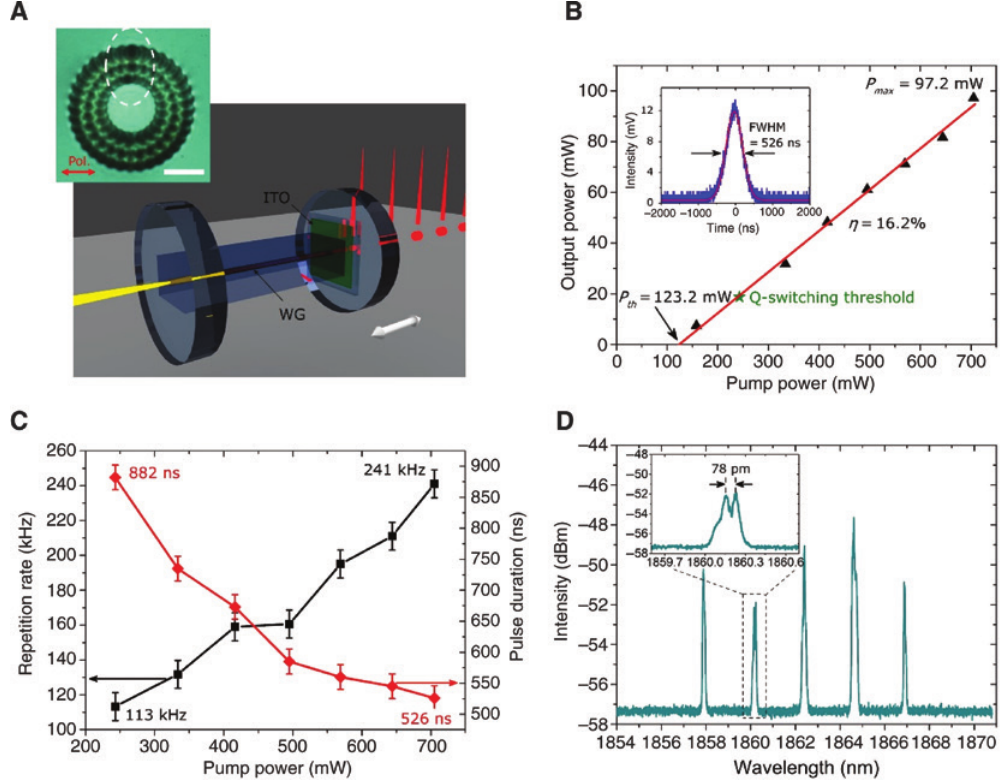
Figure 2: Q-switched WG laser performance using the ITO SA. (A) Layout of the waveguide resonator. The 790-nm pump light (yellow color) is directed by a silver mirror and focused by a planoconvex lens ( f = 50 mm). The waveguide is tightly coupled to the input coupler (IC, HT@800 nm, HR@1.9 μ m), while the ITO sample is glued on the output coupler (OC, R = 80% @ 1.9 μ m) and fitted on a piezo-actuator to finely control the air gap width (step: ~ 30 nm). Inset: the cross section of the waveguide. Pol.: polarization. The white dashed line shows the up section of the waveguide cladding where uneven = 123.2 mW, slope stress is formed. Scale bar: 50 μ m. (B) Average output power as a function of the pump power. Laser threshold P th = 97.2 mW. Inset: a temporal oscilloscope spectrum of the Q-switched pulse at the maximum efficiency = 16.2%, maximum output power P max pump power. (C) Repetition rate and pulse duration of Q-switching versus the pump power. (D) A typical optical spectrum of the Q-switching operation. The zoomed-in spectrum shows the longitudinal modes with a spacing of 78